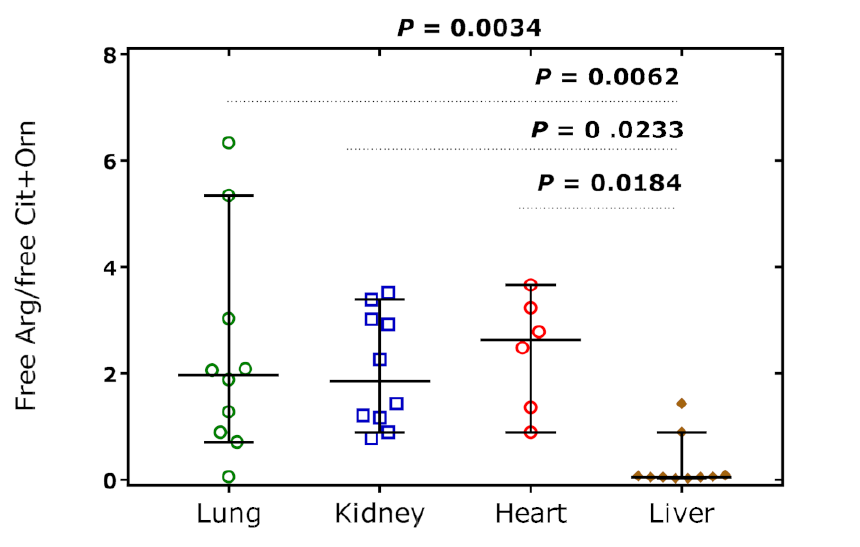
Figure 9. Molar ratio of free Arg to the summed concentration of free Cit and Orn, the global arginine bioavailability ratio (GABR), in the rat tissue organs over all time points. Data are shown as the median with 95% confidence interval ( n = 6 or 10). One-way ANOVA was performed ( p = 0.0034) with Tukey’s multiple comparisons